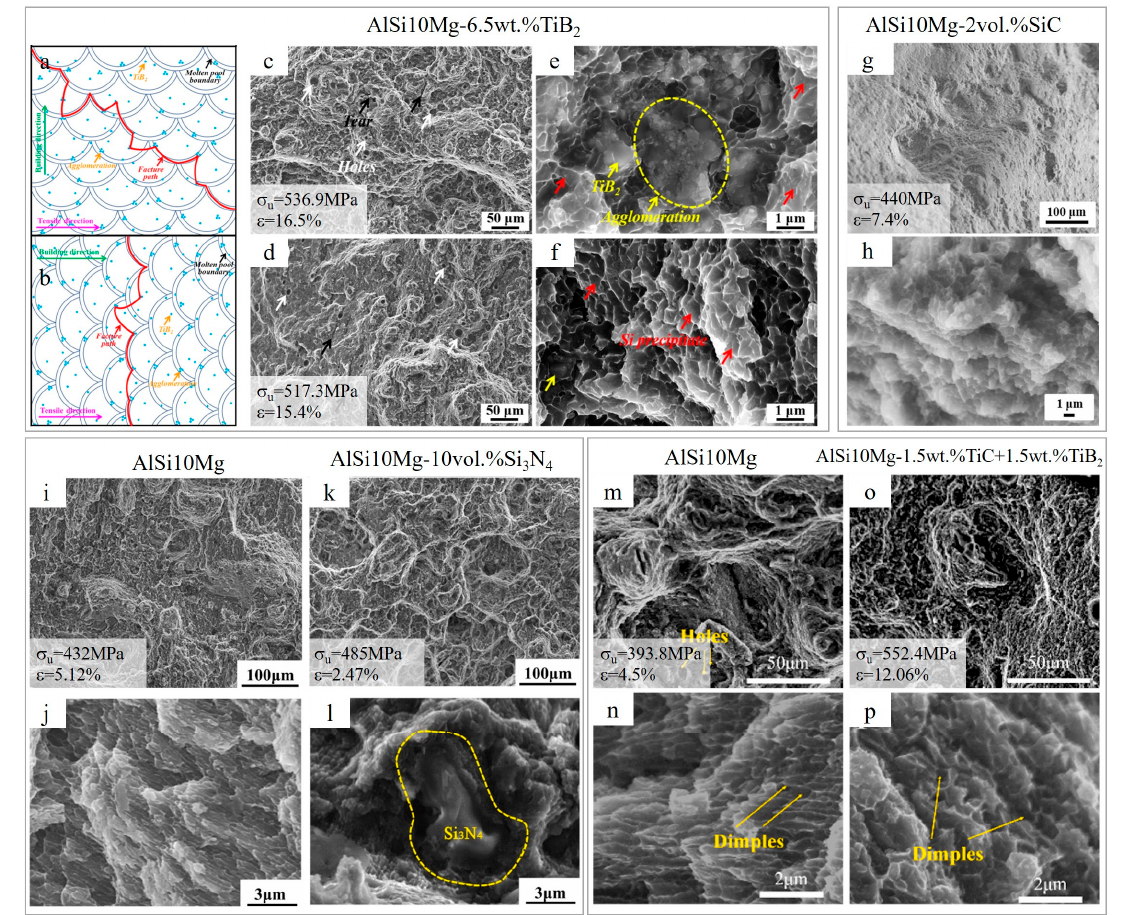
Figure 24. The schematic diagram of probable crack propagation path ( a , b ) and tensile fracture morphology for horizontal ( c , e ) and vertical samples ( d , f ) of the AlSi10Mg/6.5 wt.%TiB 2 composite. Fracture SEM images of AlS10Mg/2 vol.%SiC ( g , h ), AlSi10Mg ( i , j ) and AlSi10Mg/10 vol.%Si 3 N 4 ( k,l ) , AlSi10Mg ( m , n ) and AlSi10Mg/1.5 wt.%TiC+1.5 wt.%TiB 2 ( o , p ) (reproduced with permission from [79,93,95,104]).